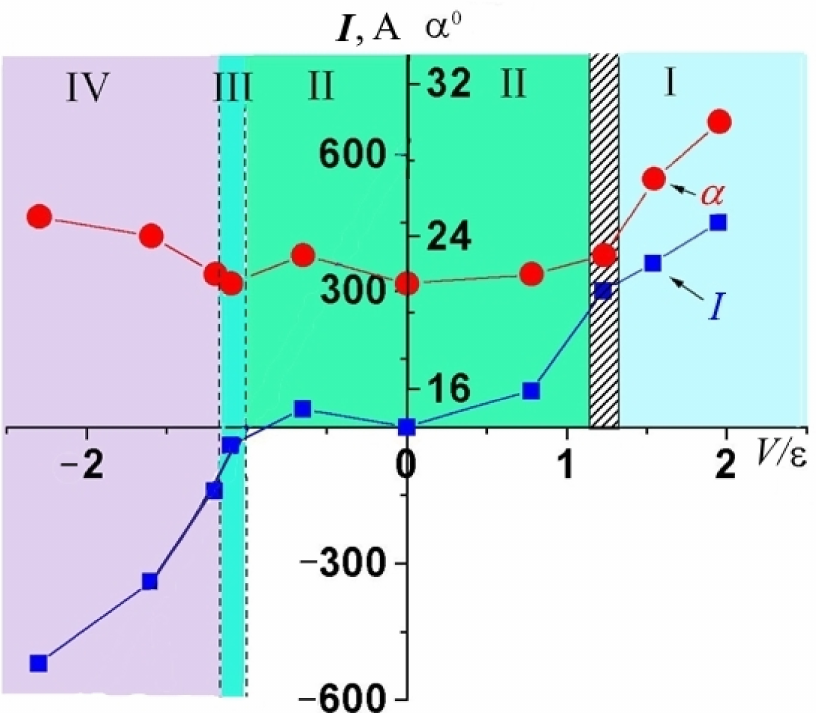
Figure 11. Dependence of the current and angle α on the ratio of the applied voltage to the magneti- cally induced EMF (B = 1.3 T, ε = 65 V): I—the area of dominance of the electric field during flow deceleration; II—the region of dominance of MHD interaction during flow deceleration; III—region of MHD flow acceleration; IV—region of dominance of the electric field in the accelerating MHD regime. The vertical lines in Figure 11 mark the boundary values of V / ε separating the